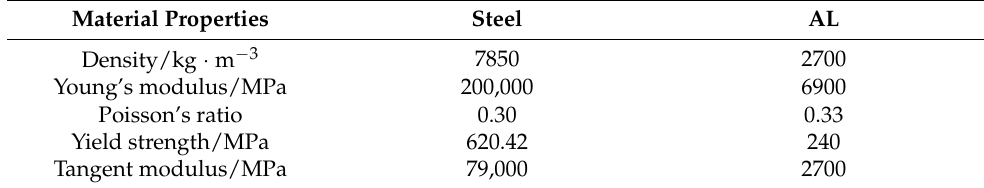
Table 1. Material parameters of the truss beam structure.